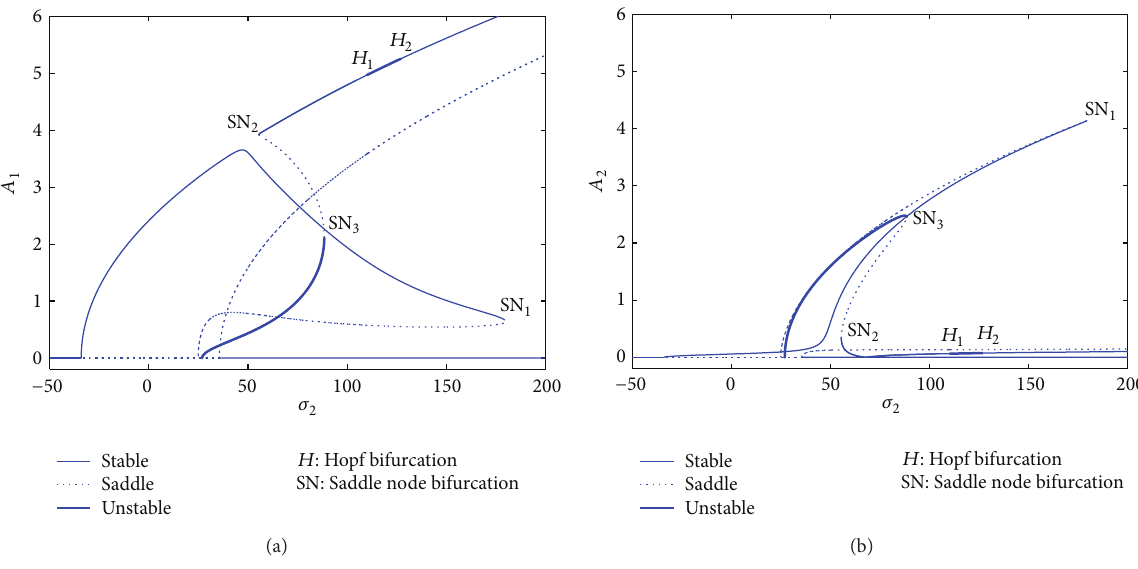
Figure 3: Frequency response curves as obtained by continuation algorithm for the first and second modes when the first mode is parametrically excited for the system parameters, Chin and Nayfeh [16].